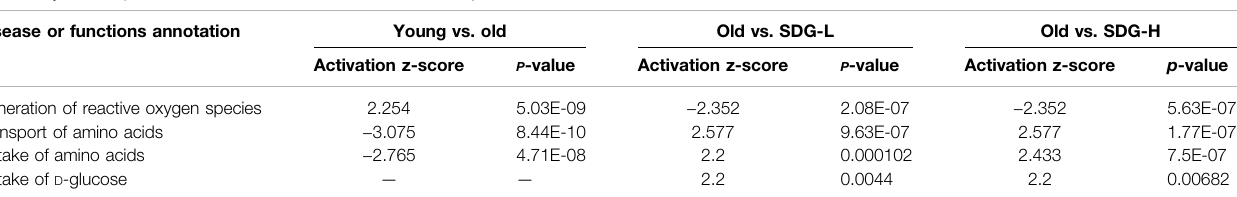
TABLE 2 | Four major disease or functions annotation identi fi ed by IPA. Disease or functions annotation Young vs. old Old vs. SDG-L Old vs. SDG-H Activation z-score P -value Activation z-score P -value Activation z-score p -value Generation of reactive oxygen